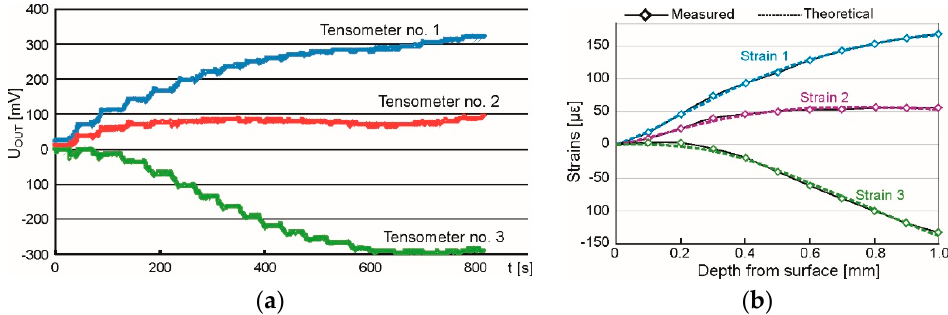
Figure 13. The overall view of testing stand ( a ) and the milling guide of RS–200 ( b ). The calculation of the strain values was made up to the depth of 1.0 mm employing Equation